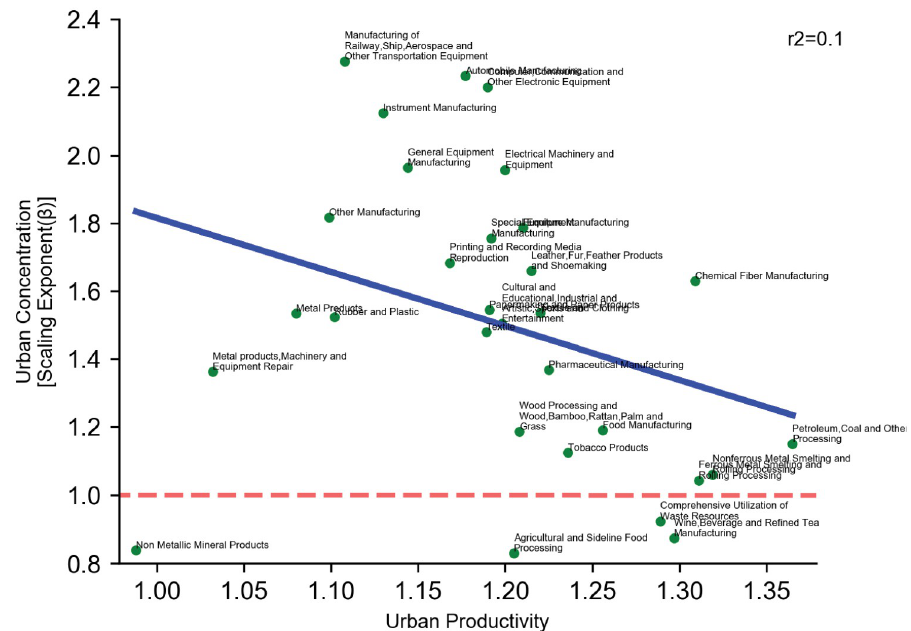
Fig 3. Urban concentration & urban productivity. The x-axis denotes urban productivity (measured by the scale elasticity). Urban concentration (measured by the scaling exponent of employment) slightly decreases with urban productivity. The blue solid line is a linear fit of the data. The red dashed line separates super-linear scaling from sub- linear scaling. Urban productivity measures returns to agglomeration by looking at the scale elasticity (scaling between employment and